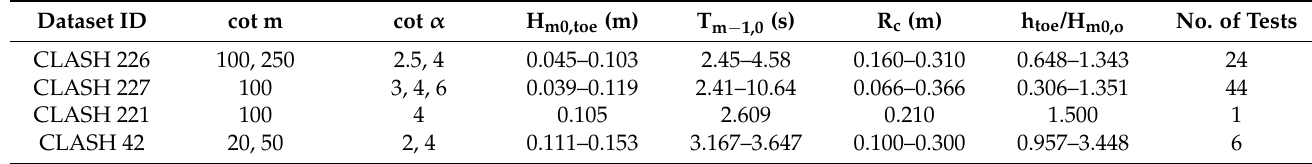
Table 3. Characteristics of the datasets selected from the CLASH